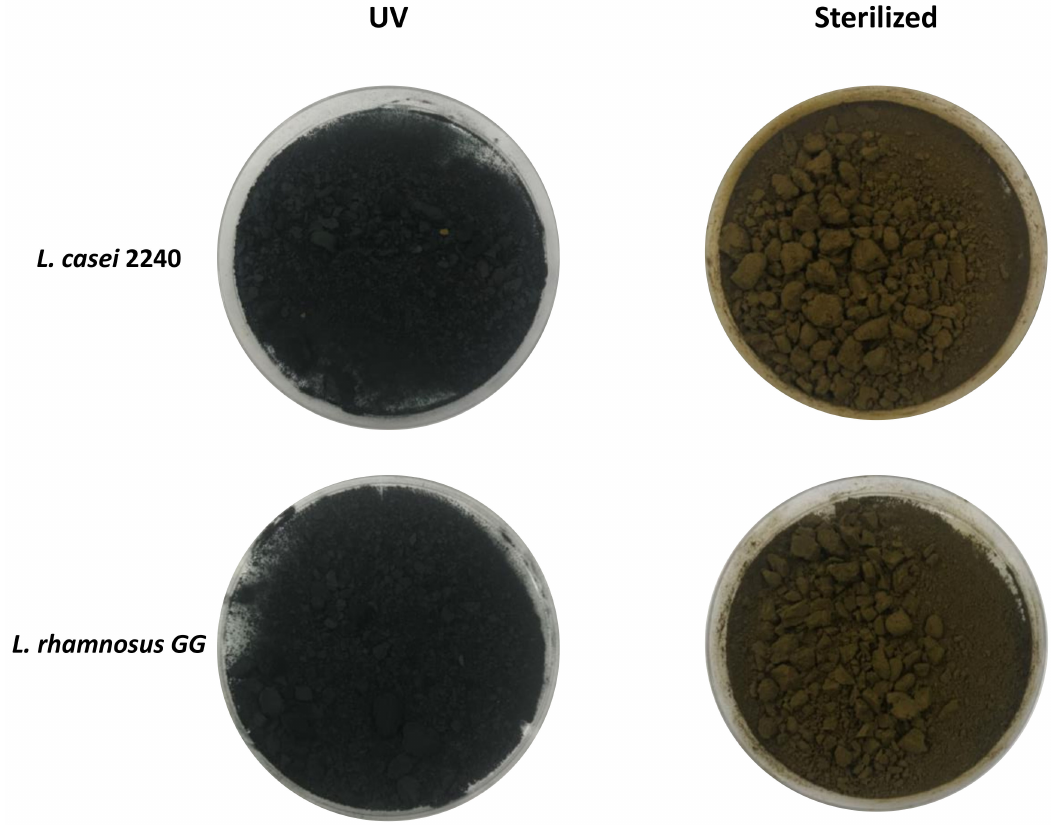
Figure 2. Representative image of fermented and lyophilized Arthrospira platensis biomasses subjected to UV and sterilization